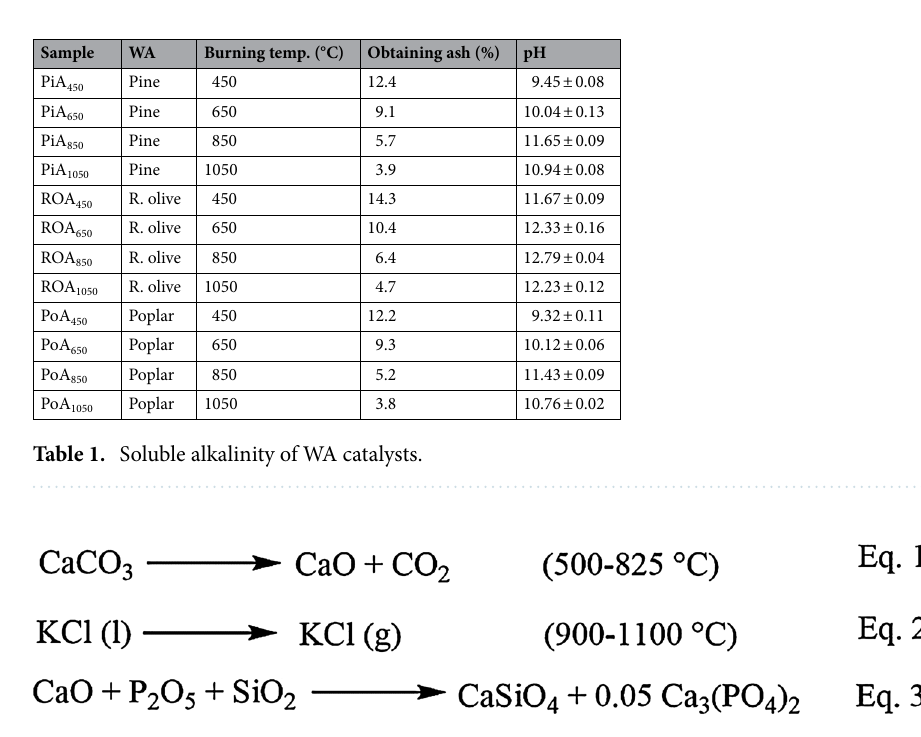
Figure 1. Thermal decomposition of CaCO 3 and formation of CaSiO 4